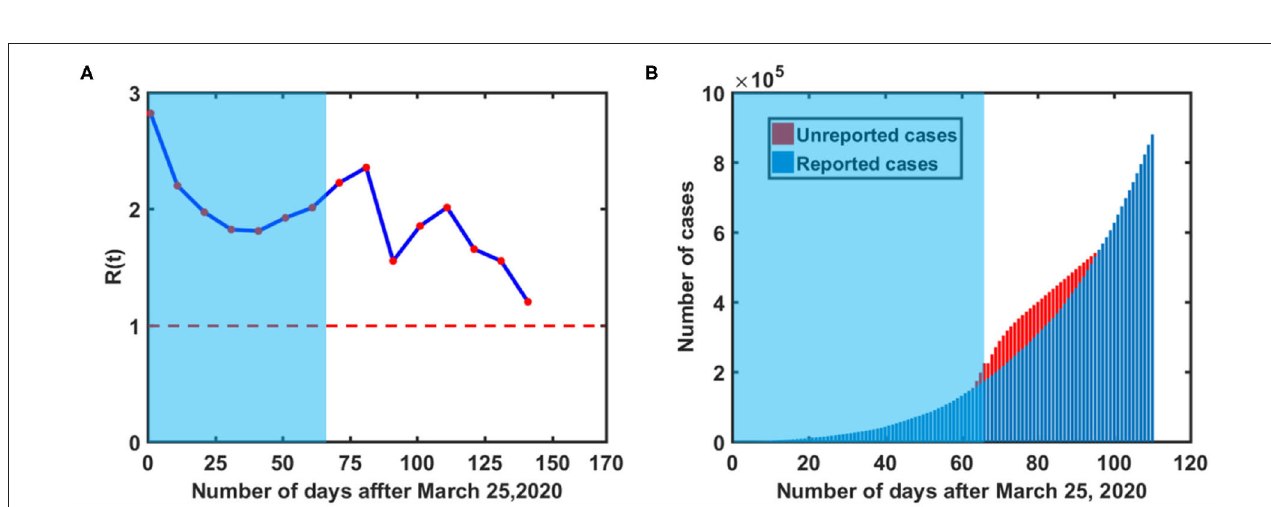
FIGURE 5 | COVID-19 reported data-based analysis during different time intervals in India, (A) Basic Reproduction number variation over time (B) estimation of underreported cases. Red colored dashed line in (A) represents the threshold value of reproduction number i.e., R(t) = 1. The red colored region in (B) represents possible under-reported cases in India. [Blue shaded region represents actual lockdown